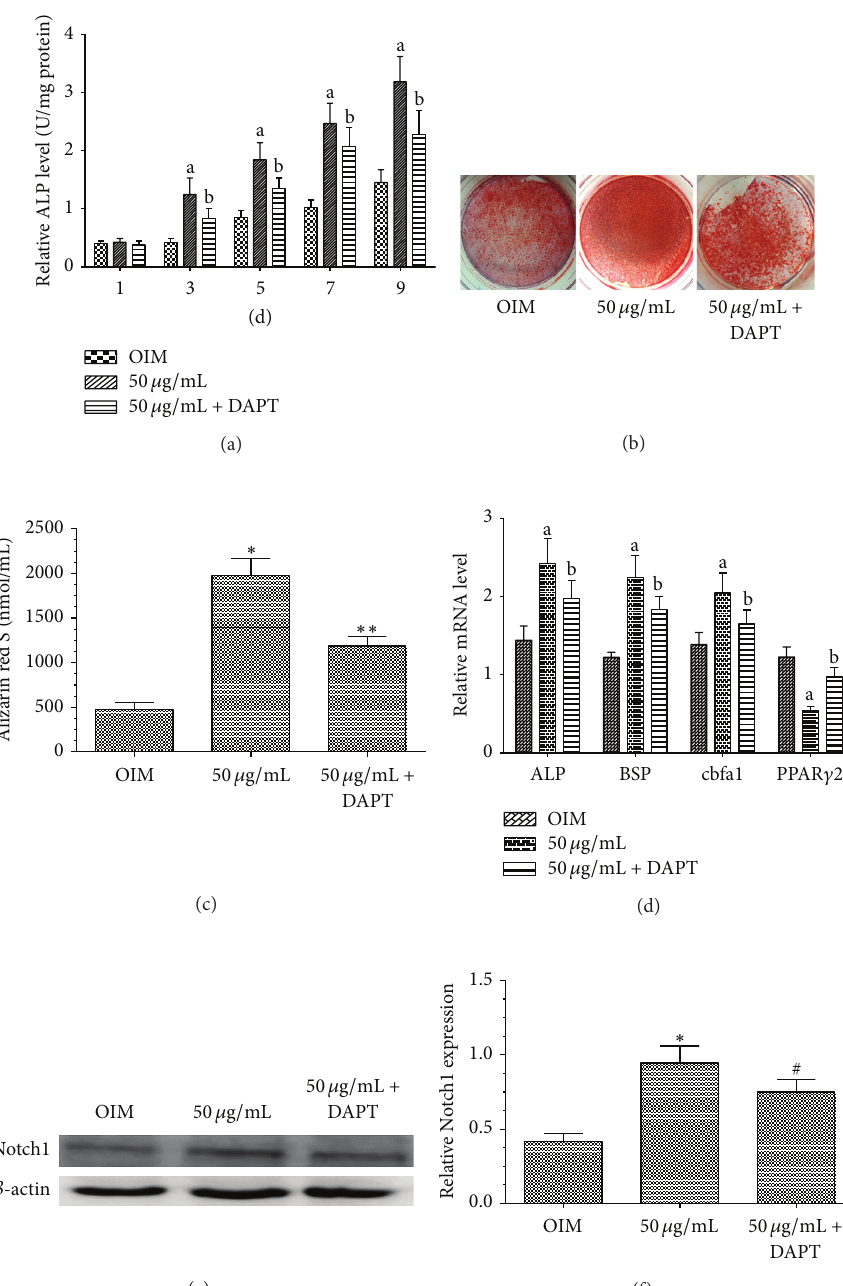
Figure 2: Involvement of Notch signaling in naringin-enhanced osteogenesis of BMSCs. (a) Effects of naringin on ALP activity of BMSCs cultured in OIM or OIM containing 50 𝜇 g/mL naringin with or without 10 𝜇 M DAPT, for 1–9 days. Data represent the mean ± SD ( 𝑛 = 4 ). a 𝑃 < 0.01 versus the OIM group; b 𝑃 < 0.01 versus the 50 𝜇 g/mL naringin group at the same time point. (b) Alizarin red S staining shows that DAPT inhibited naringin-enhanced mineralization of BMSCs. (c) Quantification and statistical analysis of calcium deposits. Data represent the mean ± SD ( 𝑛 = 5 ). ∗ 𝑃 < 0.01 versus the OIM group; ∗∗ 𝑃 < 0.01 versus the 50 𝜇 g/mL group. (d) BMSCs were cultured in OIM or OIM containing 50 𝜇 g/mL naringin with or without 10 𝜇 M DAPT, for 14 days. Expression levels of osteogenesis-related genes and PPAR 𝛾 2 were measured by RT-PCR. Data represent the mean ± SD ( 𝑛 = 5 ). a 𝑃 < 0.01 versus the OIM group; b 𝑃 < 0.05 versus the 50 𝜇 g/mL group. (e) Western blot analysis of Notch1. BMSCs were cultured in OIM or OIM containing 50 𝜇 g/mL naringin with or without 10 𝜇 M DAPT for 14 days. (f) Band density in the western blots was quantified by densitometry. Data represent the mean ± SD ( 𝑛 = 4 ). ∗ 𝑃 < 0.01 versus the OIM group; # 𝑃 < 0.05 versus the 50 𝜇 g/mL naringin